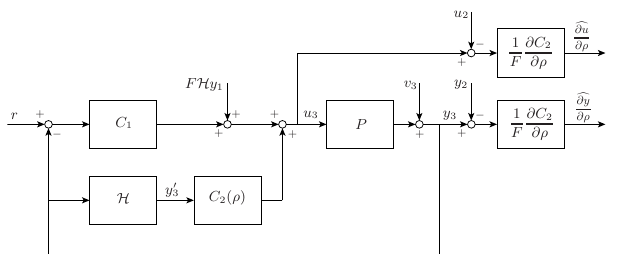
Figure 4. Block diagram of the closed-loop system, which involves multiple controllers (representing the scenario of torque control and drivetrain damping).